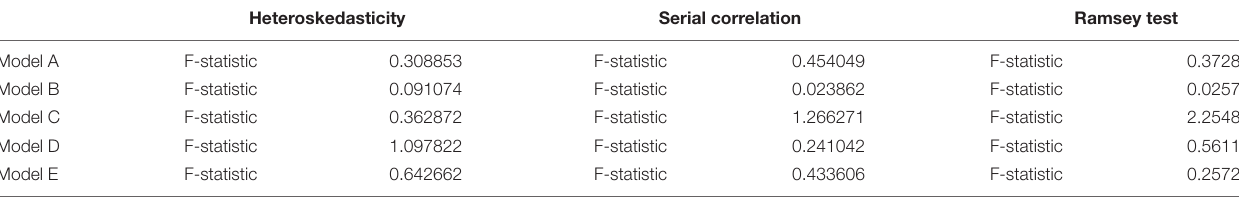
TABLE 9 | Findings of diagnostic